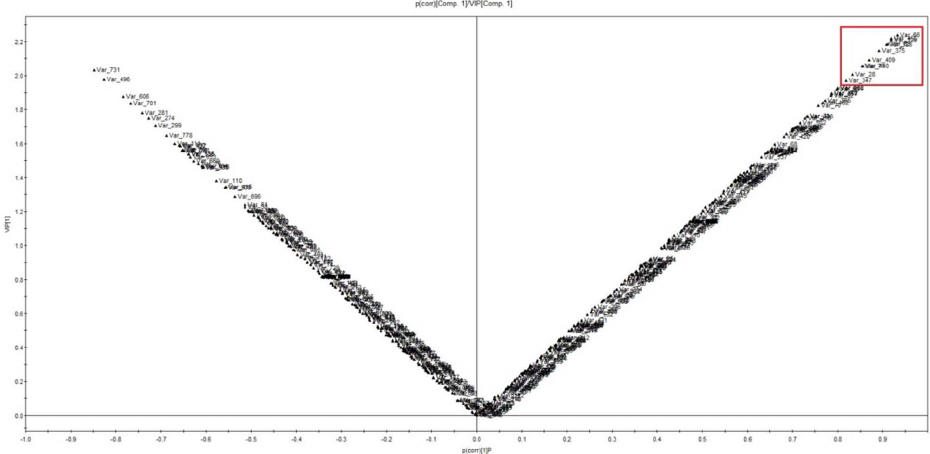
Figure 4. Scatter plot (V-plot) from OPLS-DA analysis for selecting the differential metabolites as potential markers to discriminate the groups of control and YE-treatment after 24 h.